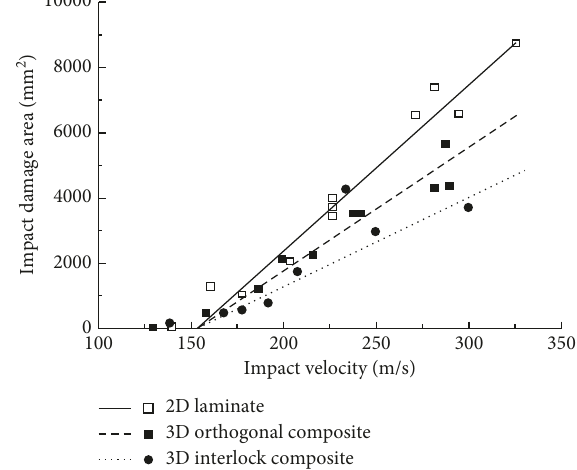
Figure 6: Influence of impact velocity on the damage surface of composite materials made with UD laminates and 3D warp in- terlock fabrics [20].